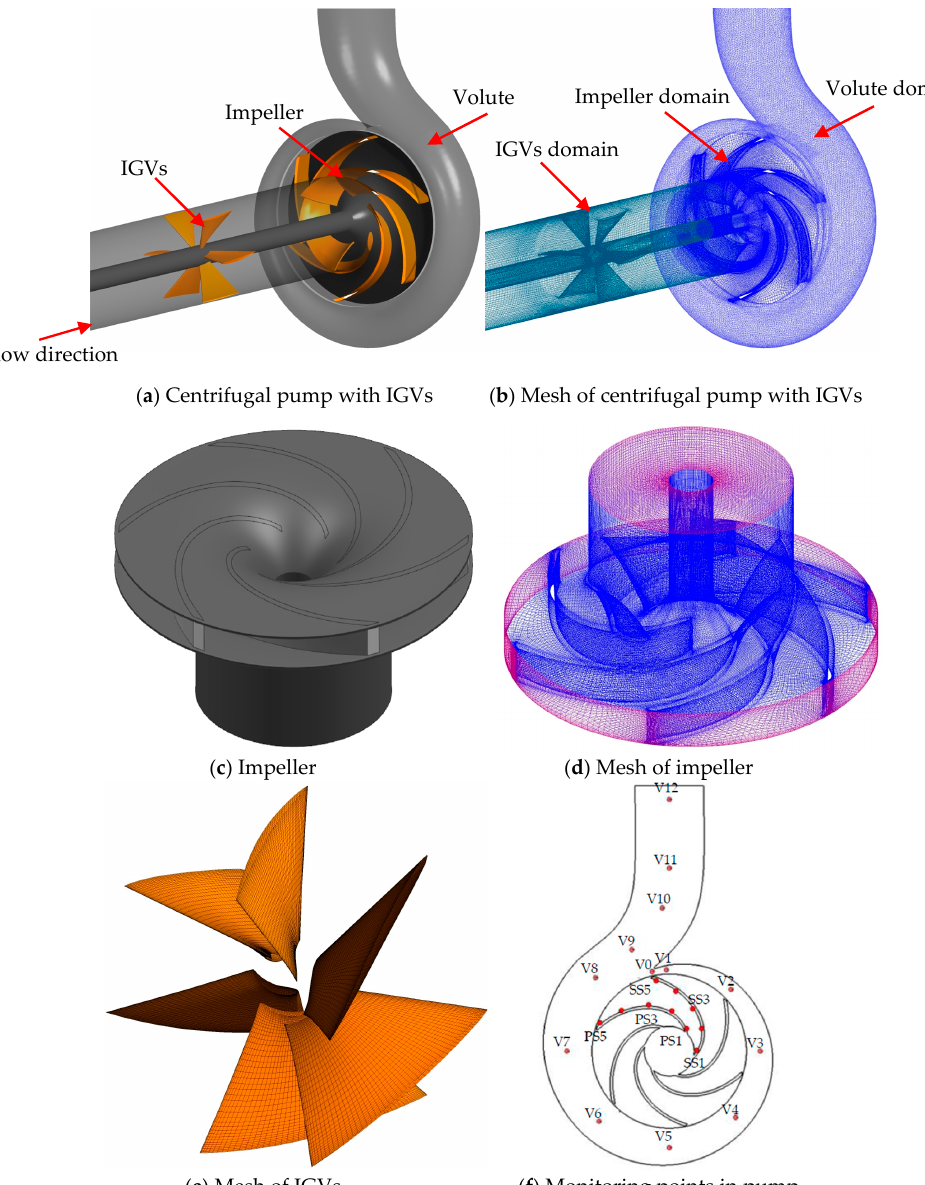
Figure 2. Computation domain, mesh, and monitor points for the centrifugal pump.